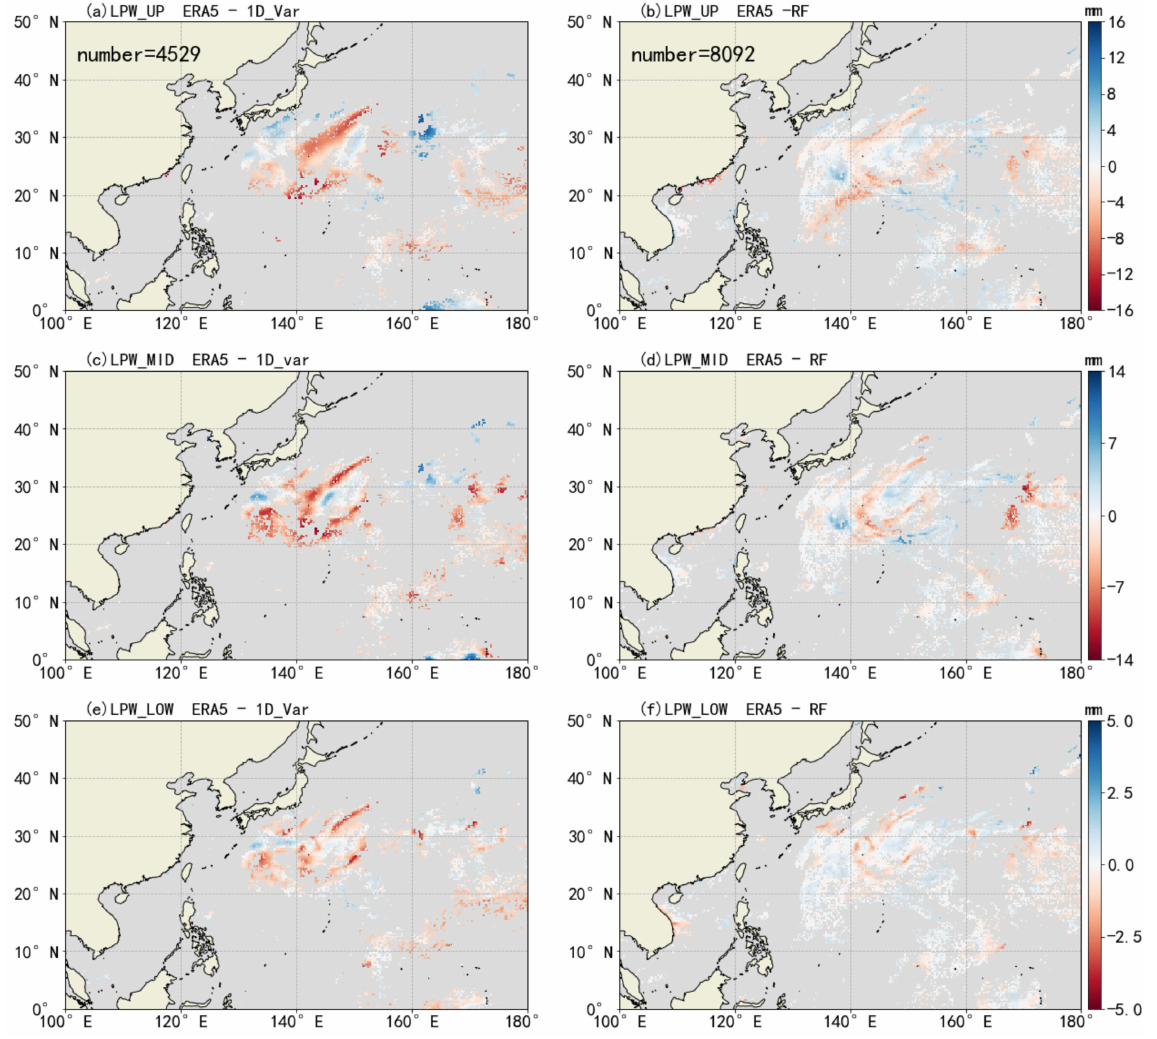
Figure 6. Differences between the ERA5 and the retrievals of water vapor at the upper ( a , b ), middle ( c , d ), and lower ( e , f ) layers by the 1DVAR ( left ) and the RF-based ( right ), respectively. (Number means the amount of the retrievals from the 1DVAR or RF-based